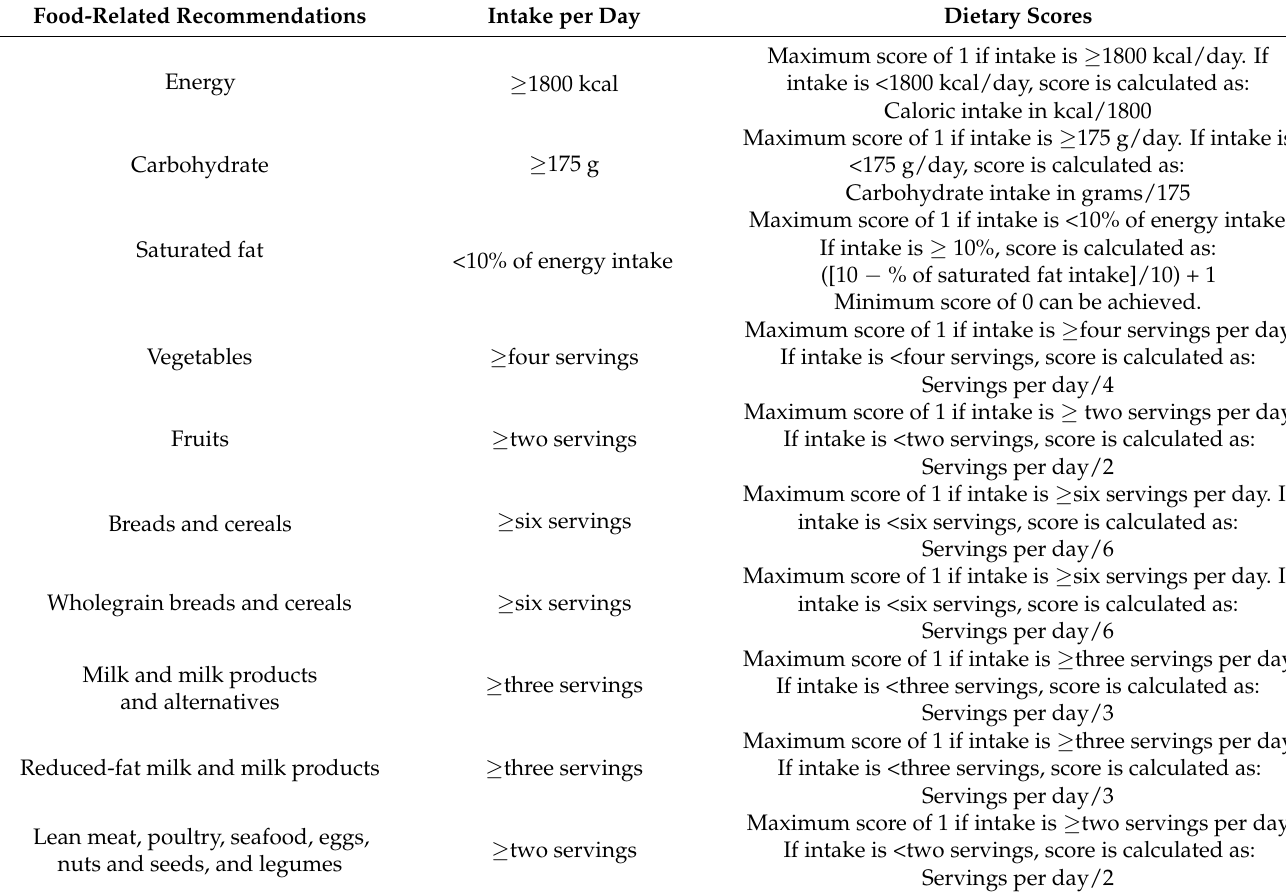
Table 1. Food-related recommendations from New Zealand dietary clinical guidelines, their cut-off values and dietary adherence score